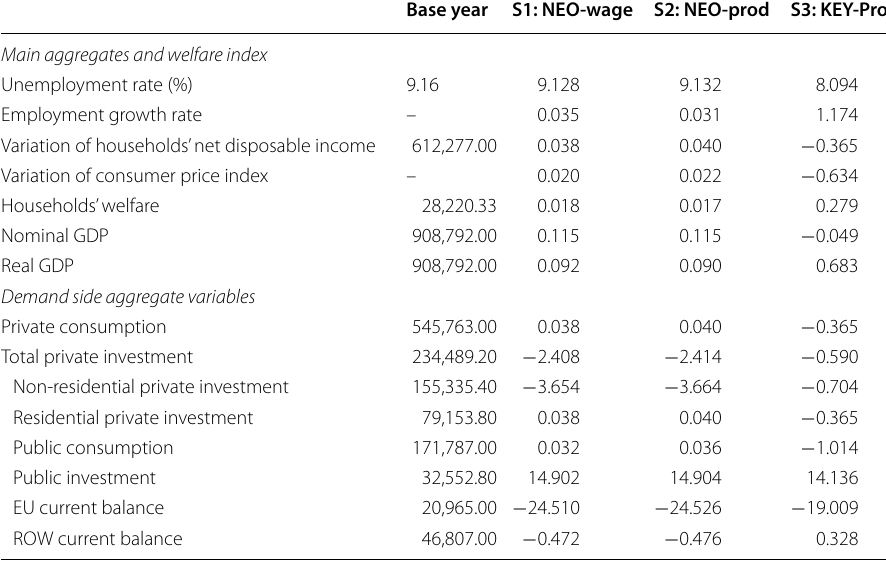
Table 7 Elasticities on the wage rate (S1) and elasticities of production multiplied (S2 and S3) by 1.25